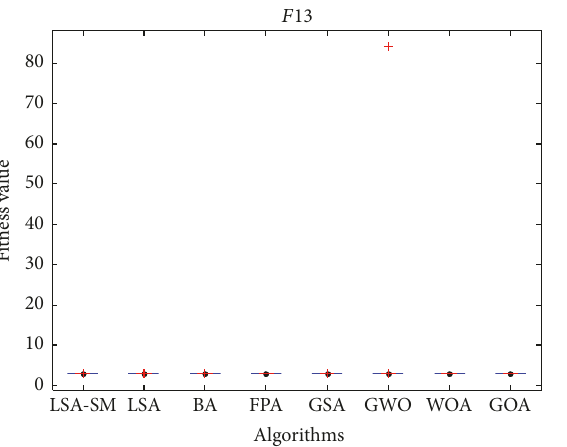
Figure 38: 𝐷 = 4 , ANOVA test of global minimum for 𝑓 16 .